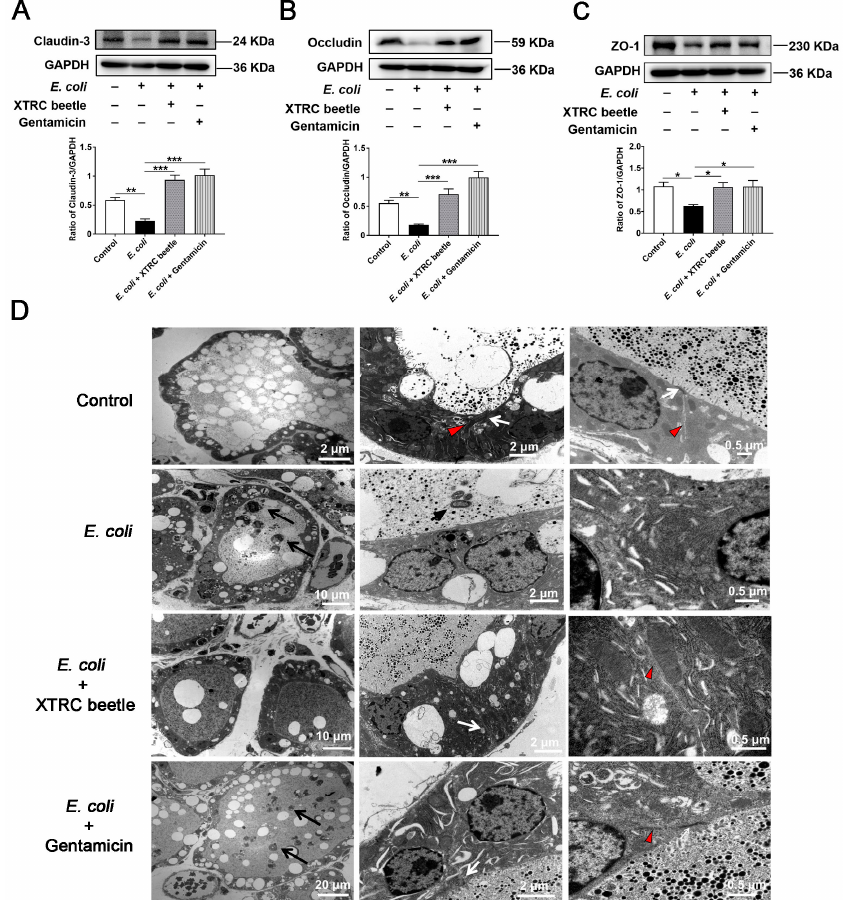
Figure 4. Effect of Z. morio hemolymph on the integrity of blood–milk barrier in E. coli -induced mastitis. ( A – C ) Western blotting analysis of Claudin3, Occludin and ZO-1 in mammary tissues. The panel shows the protein quantification using ImageJ software (version 1.50). ( D ) Representative transmission electron micrograph (TEM) images in each group. Microvilli are formed at the surface of luminal cells. MECs are connected by cell junctions. Long black arrows, neutrophils infiltration in acinar cavity; Short black arrows, E. coli ; white arrows, desmosomes; red triangles, tight junctions (TJs). XTRC beetle stands for Z. morio hemolymph-treatment. Data presented are means ± SEM ( n = 8 per group). * p < 0.05, ** p < 0.01, *** p < 0.001. 2.5. Z. morio Hemolymph Inhibits E. Coli-Induced Inflammatory Response in PMECs